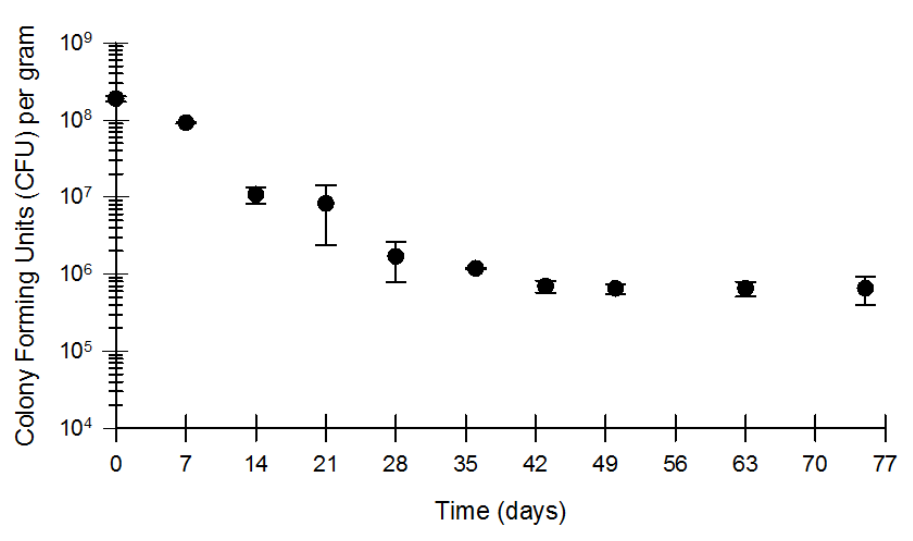
Figure 1. Viability of bacterial sourdough culture on dried, fermented brewers spent grain. The data shown are the average and standard deviation of triplicate determinations.